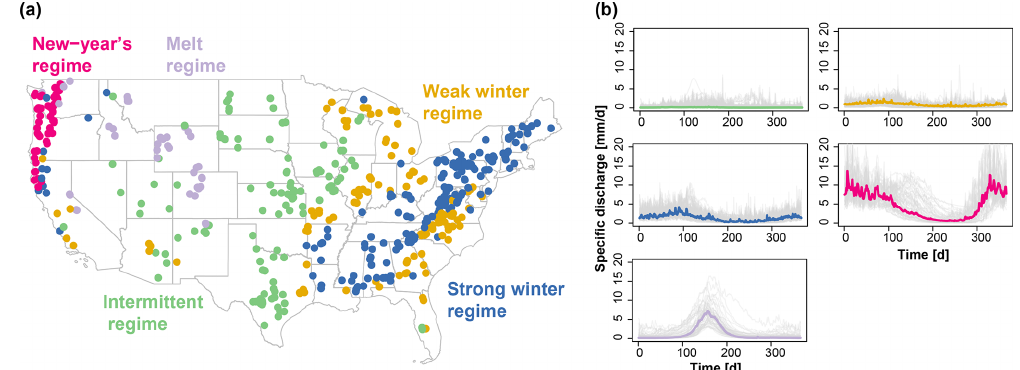
Figure 1. (a) Map of the 488 catchments in the conterminous United States belonging to the five regime classes indicated by their gauge location: (1) intermittent, (2) weak winter, (3) strong winter, (4) New Year’s, and (5) melt. (b) Median regime per regime class (colored lines) and variability of regimes within a class (one line per catchment, grey) (Brunner et al.,